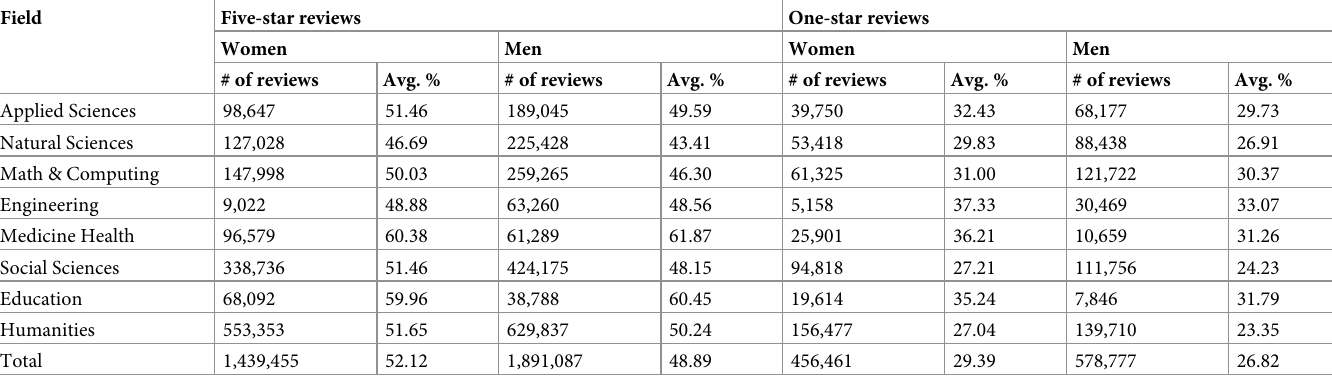
Table 4. Distributions of five- and one-star review numbers and percentages by professor gender and